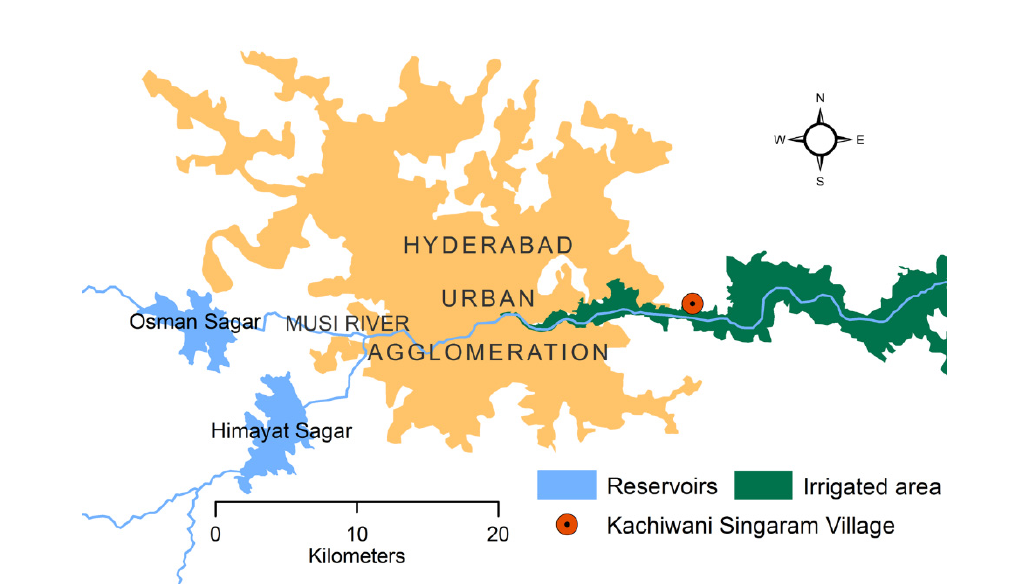
Figure 1. Irrigated areas in and downstream of Hyderabad city